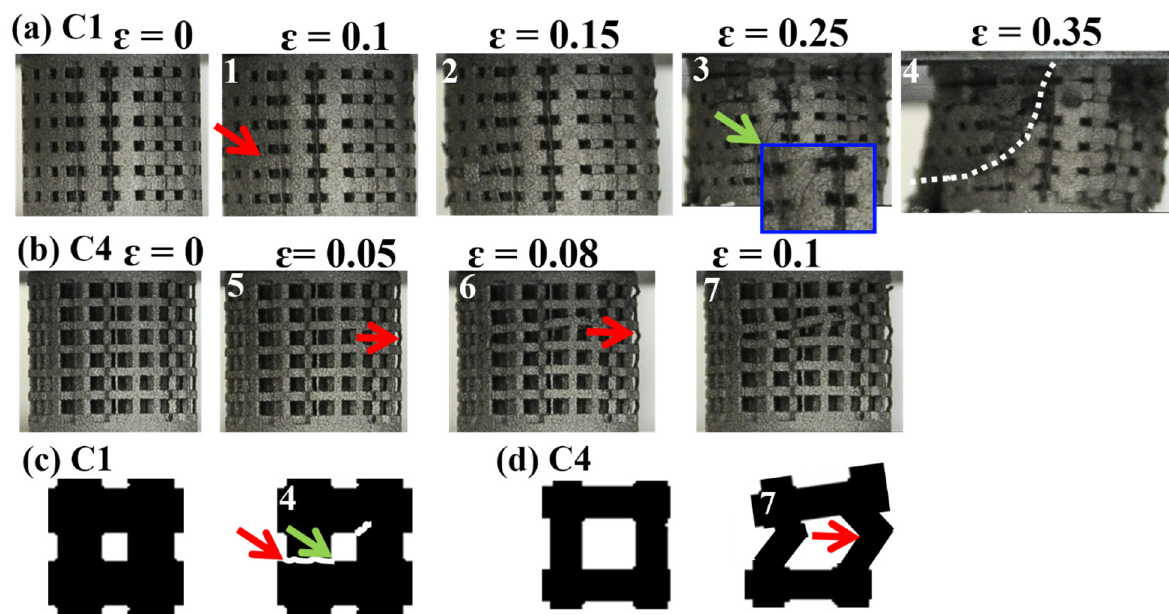
Figure 4. Images of (1)–(4) and (5)–(7) sites in the stress–strain curve in Figure 3. The possible stress concentration region observed here is denoted by red arrows, and the diagonal crack is denoted by green arrows. ( a ) C1 specimen in the elastic region with increased compressive strain: the crack was found at the edge at point 1 ( ɛ = 0.1). Struts were over the elastic region where vertical and horizontal struts collapsed at point 2 ( ɛ = 0.15) and a diagonal crack at point 3, and the following shear diagonal collapse manner is denoted by the white line at point 4 ( ɛ = 0.35). ( b ) C4 specimen with an increased compressive strain: the initial crack is located in the center of the vertical struts at point 5 ( ɛ = 0.1); bulking vertical strut deformation then induced horizontal strut collapse at points 6 and 7, leading to layer-by-layer collapse. Proposed fracture behavior for C1 specimen in ( c ) and for C4 specimen in ( d ).